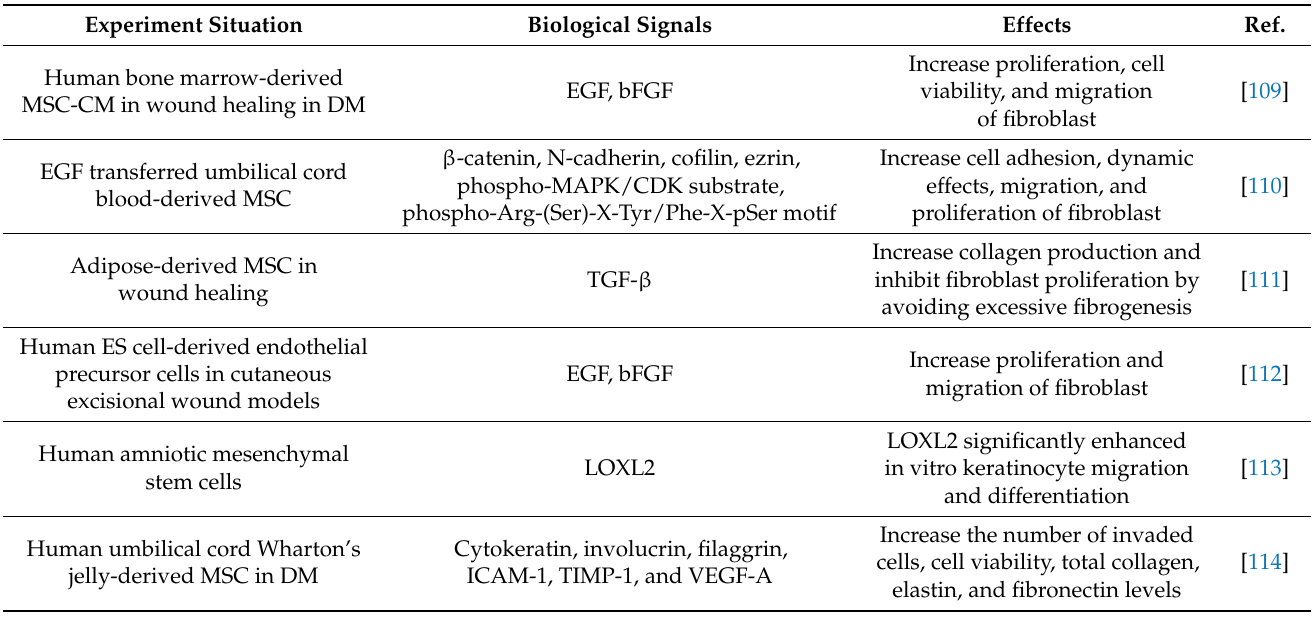
Table 1. MSC functions on fibroblast under different